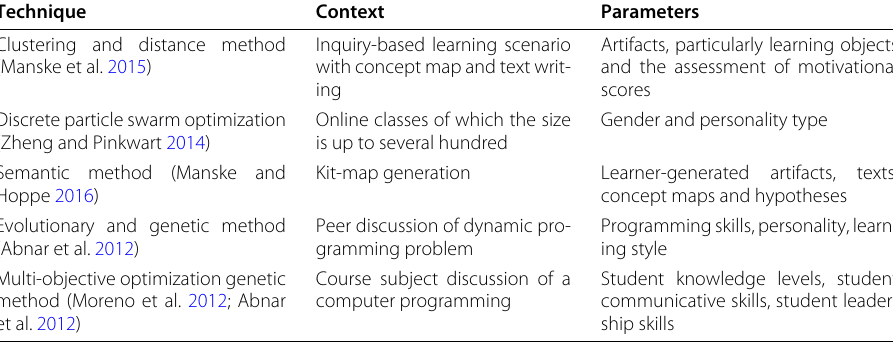
Artifacts, particularly learning objects and the assessment of motivational scores Gender and personality type concept maps and hypotheses